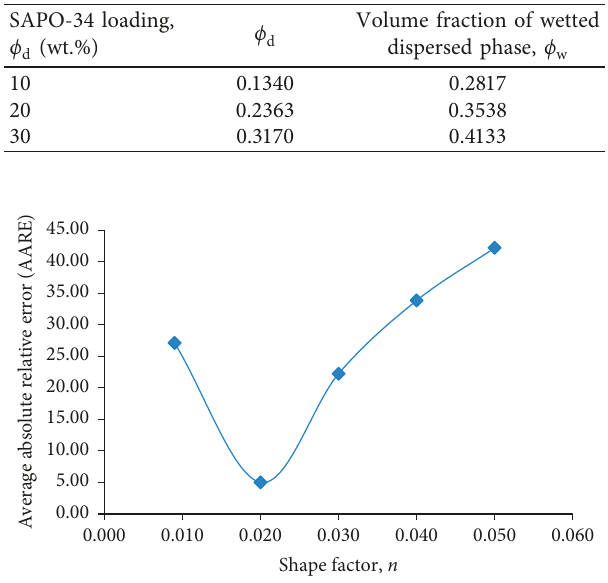
Figure 6: Optimization curve of shape factor, n , through a shape factor data fitting.